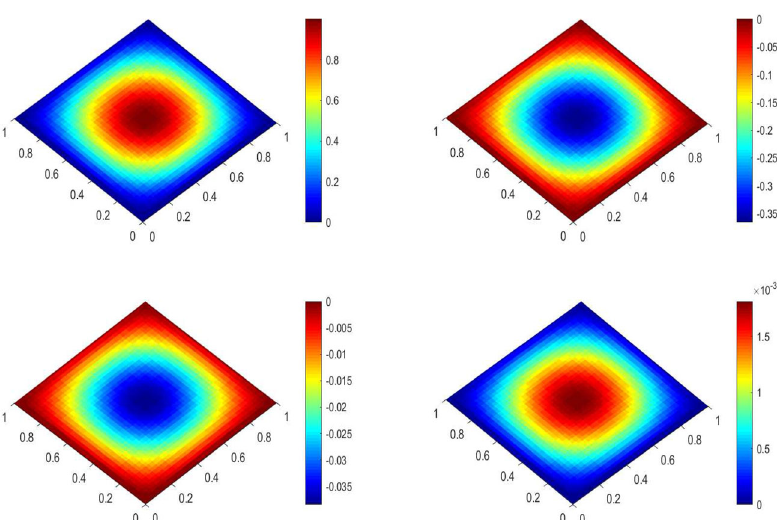
Fig. 2 The numerical solution plots for t = 0 (top-left), t = 10 (top-right), t = 50 (bottom-left), and t = 100